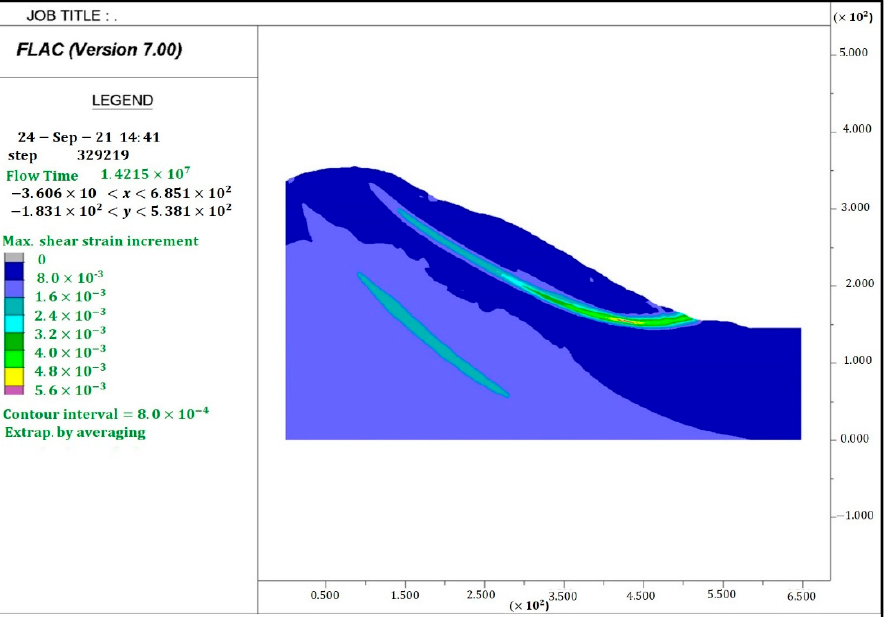
Figure 19. The distribution of the maximum shear strain increment from the numerical analysis of the slope model without geological structure (state 1). The distribution of the maximum shear strain suggested a deeper and larger potential sliding surface.